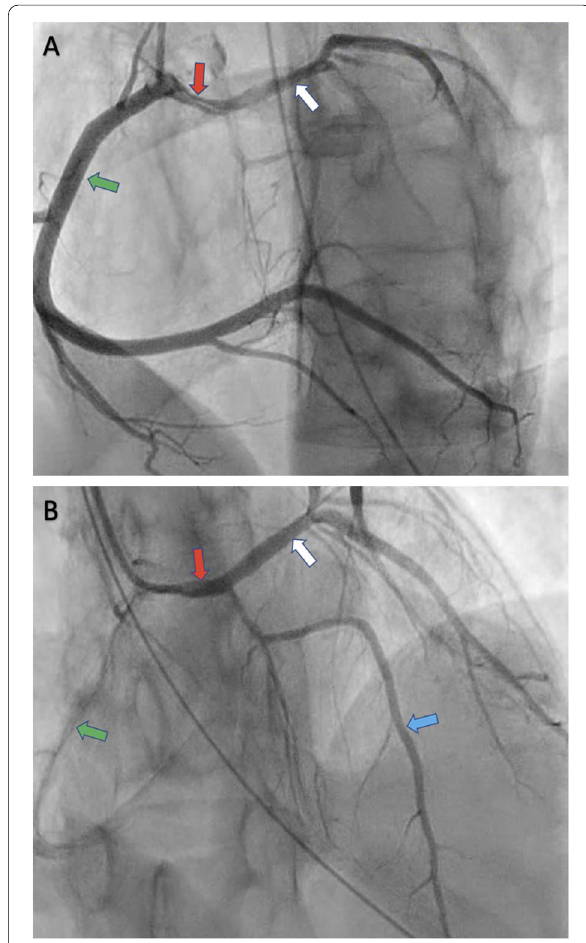
Fig. 1 Invasive coronary angiography (preoperative). A A cranial left anterior oblique projection. B A cranial right anterior oblique projection. Both images demonstrate the right coronary artery (green arrows) and the anomalous left main coronary (red arrows) before it bifurcates into the relatively small calibre left anterior descending (LAD) (blue arrow) and left circumflex arteries (white